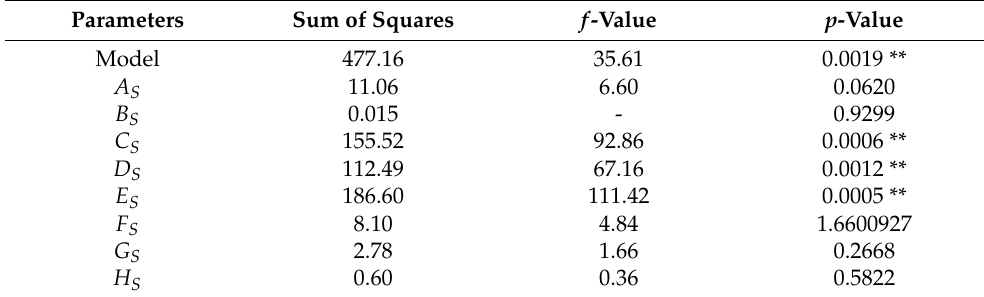
Table 7. ANOVA for the results of the Plackett–Burman design test.